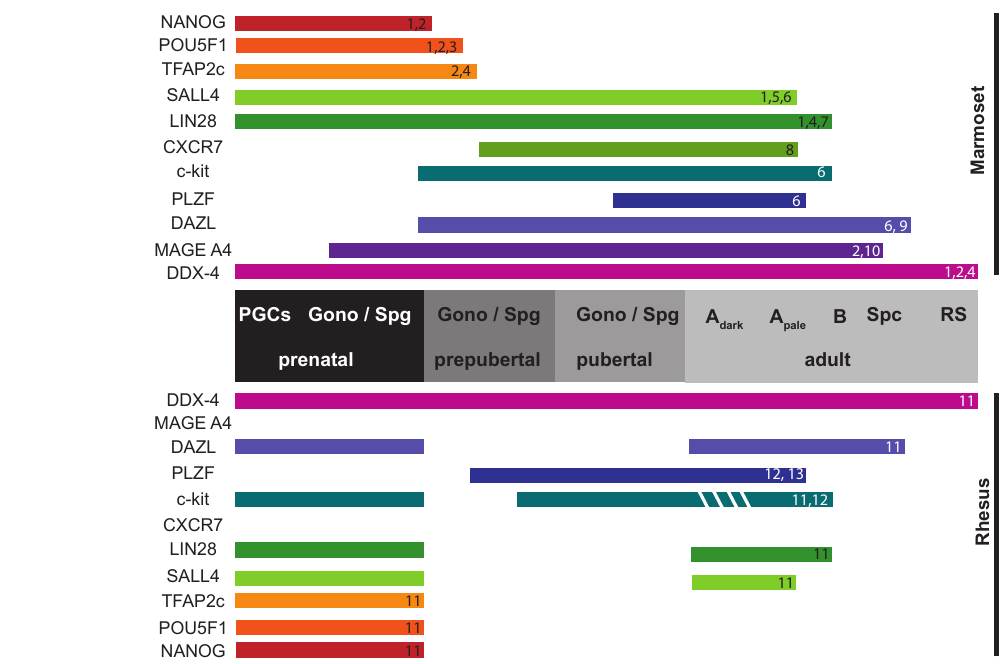
Figure 1. Schematic representation of comparative expression profiles of prenatal, perinatal and adult germ cell markers in marmoset and rhesus monkeys. Prenatally expressed markers constitute primordial germ cells (PGCs), the embryonic precursors of male gametes, and gonocytes (Gono), cells located in seminiferous tubules. Prespermatogonia are the cells migrating to the basal lamina, whereas spermato- gonia (Spg) are already in direct contact with basal lamina. A sub-population of these spermatogonial stem cells further mature into more differentiated cells including B spermatogonia (B), spermatocytes (Spc), round (RS) and elongated spermatids, and finally into spermatozoa. Expression patterns of various germ cell markers across different developmental stages are represented by colored bars (1: Aeckerle et